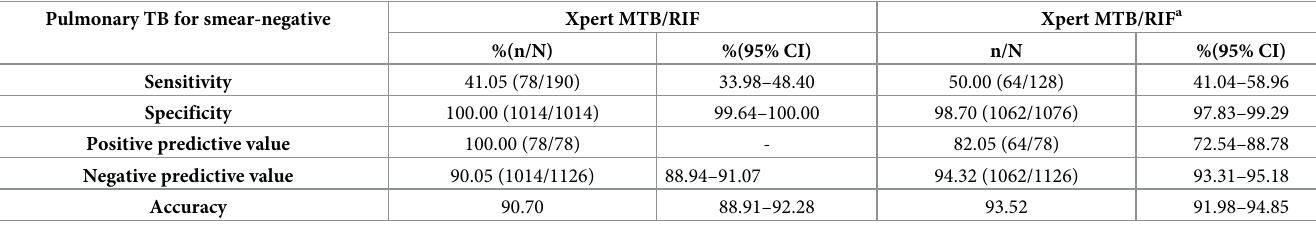
Table 1. Diagnostic performance of sputum Xpert MTB/RIF for smear-negative pulmonary TB.